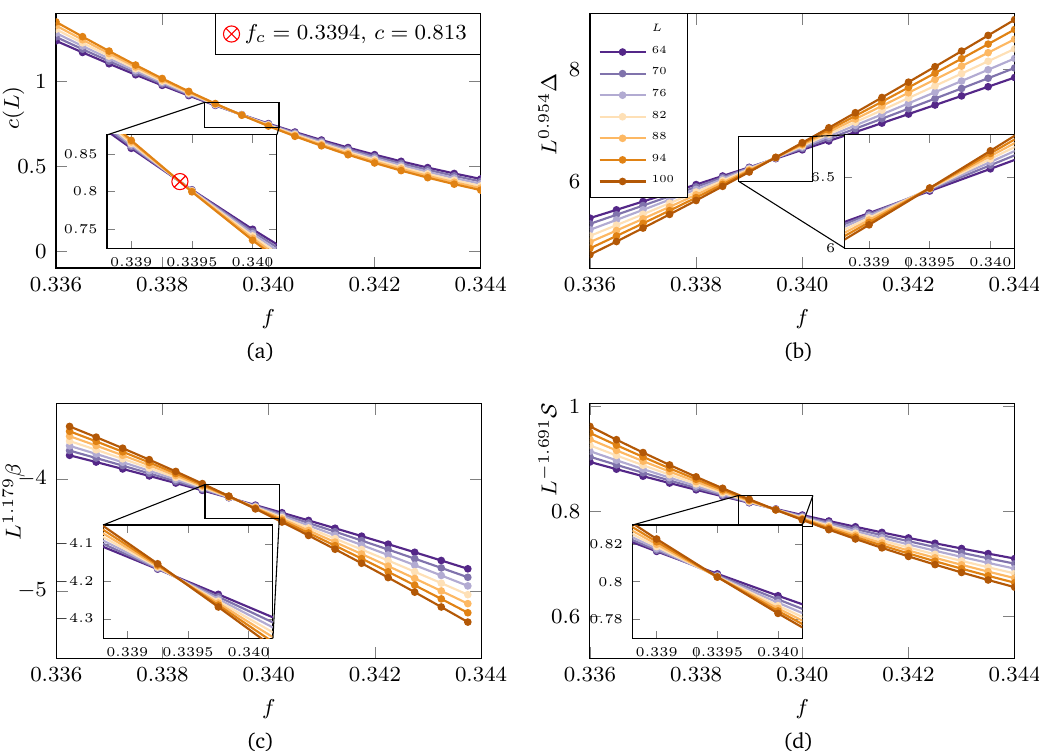
= 0.3394 Figure 4: Finite-size results for U = − 0.5, locating the transition at f c = 100). From (b) we confirm the from the central charge (a) with c ≈ 0.813 ( L max dynamical exponent is close to 1. From the Callan–Symanzik β function in (c) we derive 1 /ν ≈ 1.179 and the structure factor gives 2 − η = 1.691. The exponents in S (b), (c) and (d) are obtained by requiring that the finite-size data are independent of L at the transition f c